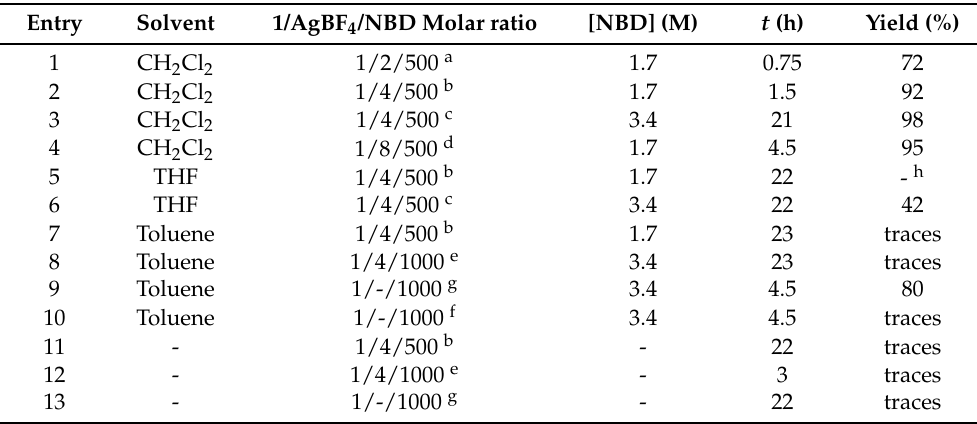
Table 5. Polymerization of norbornadiene (NBD) with the catalytic system 1/ AgBF 4 .